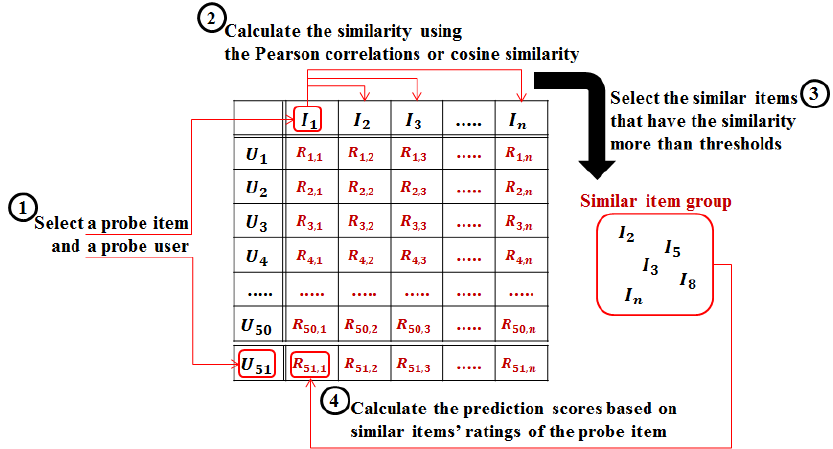
Figure 8. Entire process for tests of the recommendation systems based on the item-based filtering.